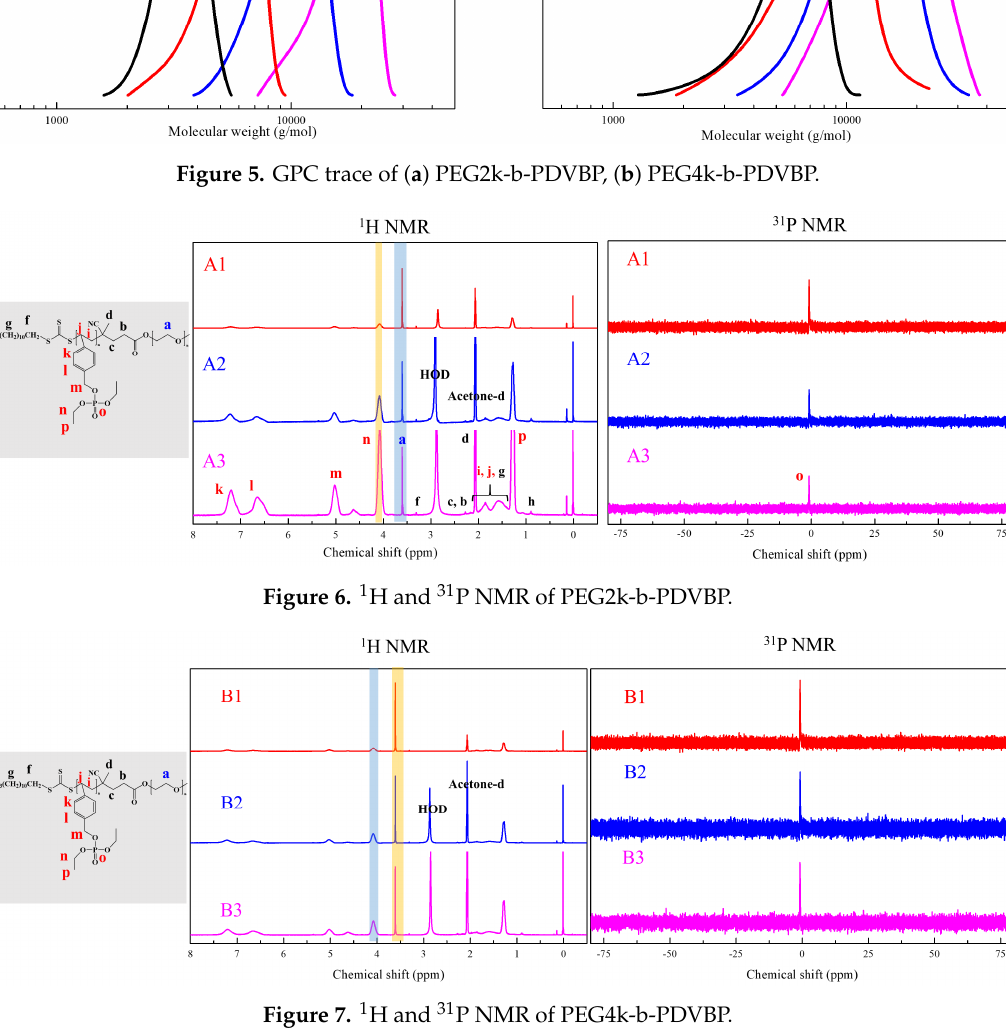
Figure 7. 1 H and 31 P NMR of PEG4k-b-PDVBP.